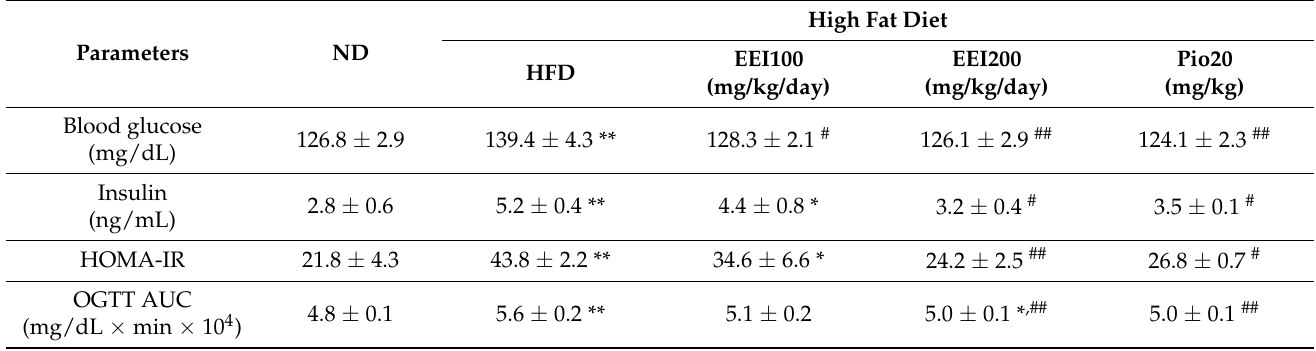
Table 2. The effect of 2-week feeding EEI on blood glucose, insulin, HOMA-IR, and OGTT of rats.